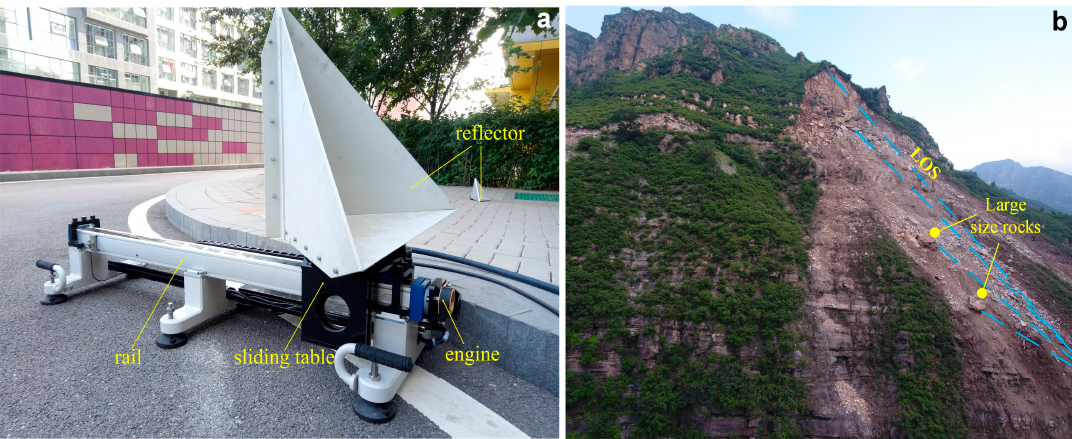
Figure 3. ( a ) Linear sensor system employed to generate controlled displacement; ( b ) A mountain rockslide, the movement of corner reflector simulates the displacement of giant rocks on the surface of the rockslide accumulation zone. Blue dashed line shows the LOS direction, and yellow line marks two large size rocks on the slope surface.